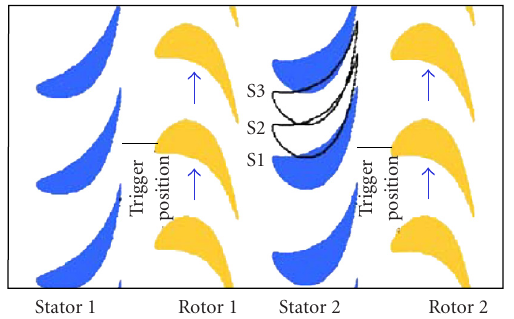
Figure 1: Stage configuration on